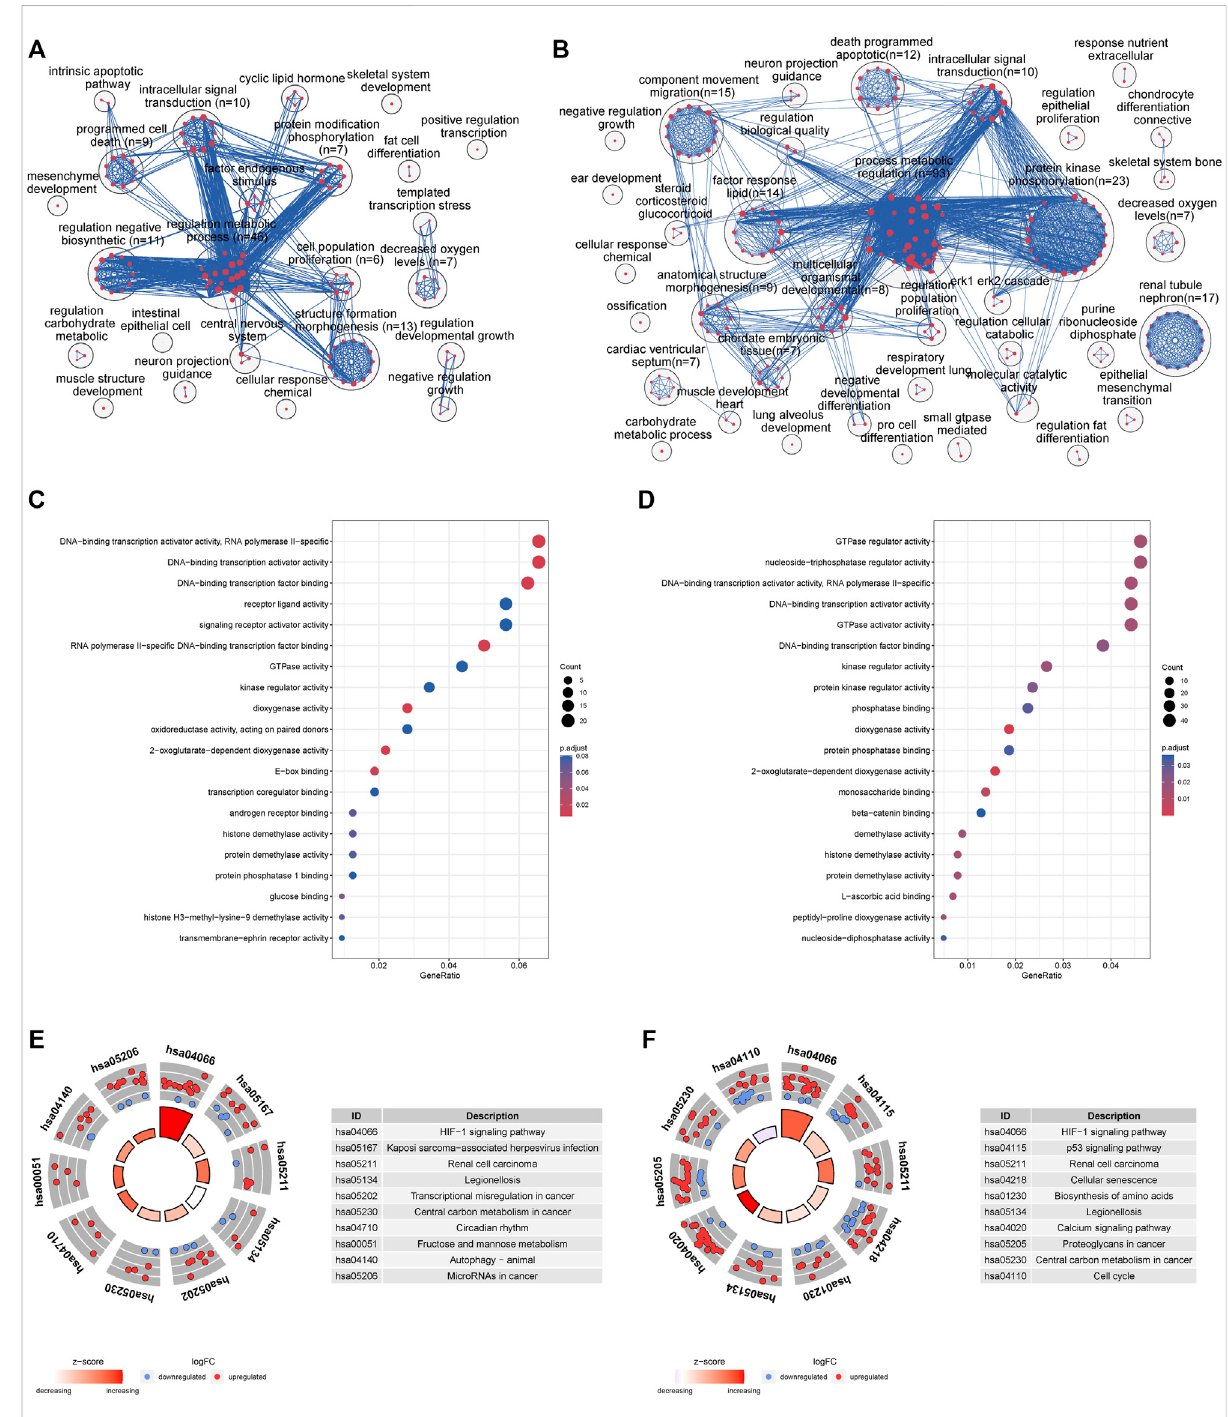
FIGURE 3 (A) Enrichment analysis identi fi ed over 500 signi fi cantly enriched biological processes that were clustered using EnrichmentMap and AutoAnnotate in Cytoscape to identify the key biological processes involved in oxygen-glucose deprivation at 4 h. Nodes represent individual GO terms, with size relating to the number of genes in each term and the color indicating enrichment signi fi cance. Edges represent connections betweennodesthatsharegenes. (B) Enrichmentanalysisat8 h (C) GOenrichmentanalysesofthetop20mostsigni fi cantlyenrichedmolecular functions oftheshared DEGs at4 h (D) GO enrichmentanalyses ofthetop 20mostsigni fi cantly enriched molecular functionsofthesharedDEGsat 8 h (E) KEGG enrichment analyses of the top 10 most signi fi cant pathways at 4 h; the inner ring is a bar plot where the bar height indicates the signi fi cance of the term ( − log10 p value), and the color indicates the z score. The outer ring displays scatterplots of the expression levels (log2-fold change) for the genes in each term. (F) KEGG enrichment analyses of the top 10 most signi fi cant pathways at 8